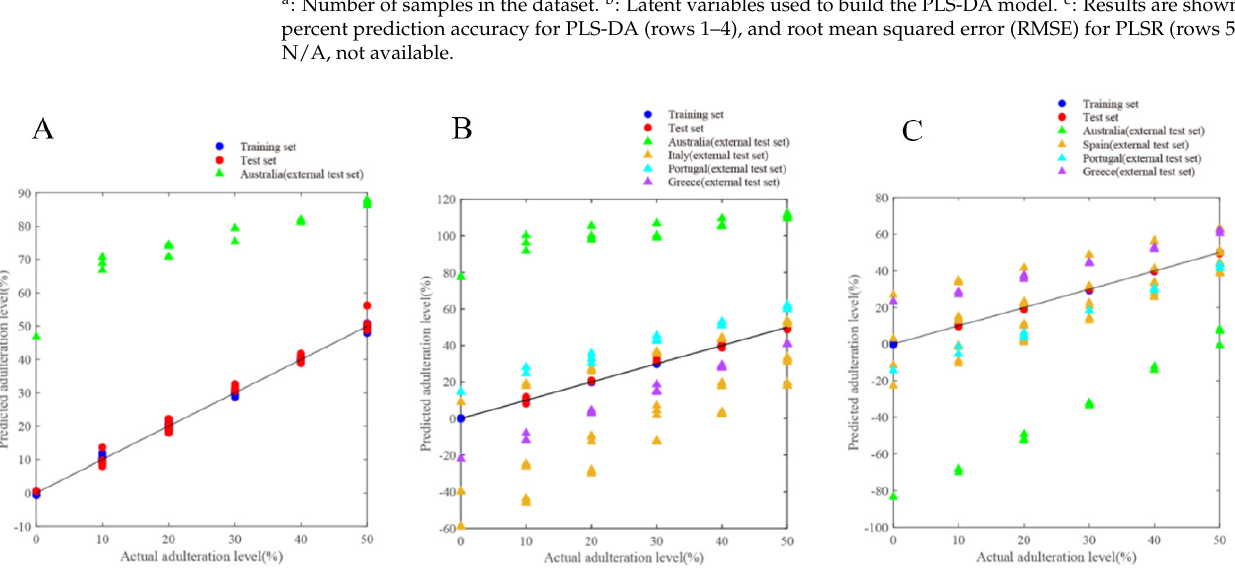
Figure 5. Local partial least-squares regression (PLSR) model predictions. ( A ) European. ( B ) Spanish. ( C ) Italian. The black line starts from the origin with a slope of 1, representing the ideal regression result. All predictions from the training, internal, and external test sets are plotted in colored markers in each subfigure for better comparison. Table 1. EVOO adulteration prediction by UV-Vis spectra according to geographical origins.